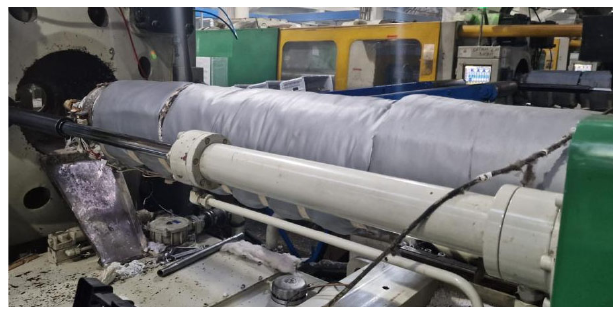
Figure 14. Insulation jackets for an extrusion machine.